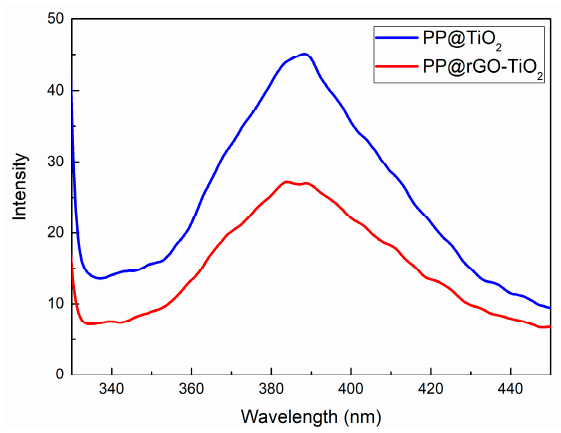
Figure 7. PL spectra of PP@TiO 2 and PP@rGO-TiO 2 photocatalysts containing 0.125 mg of rGO .